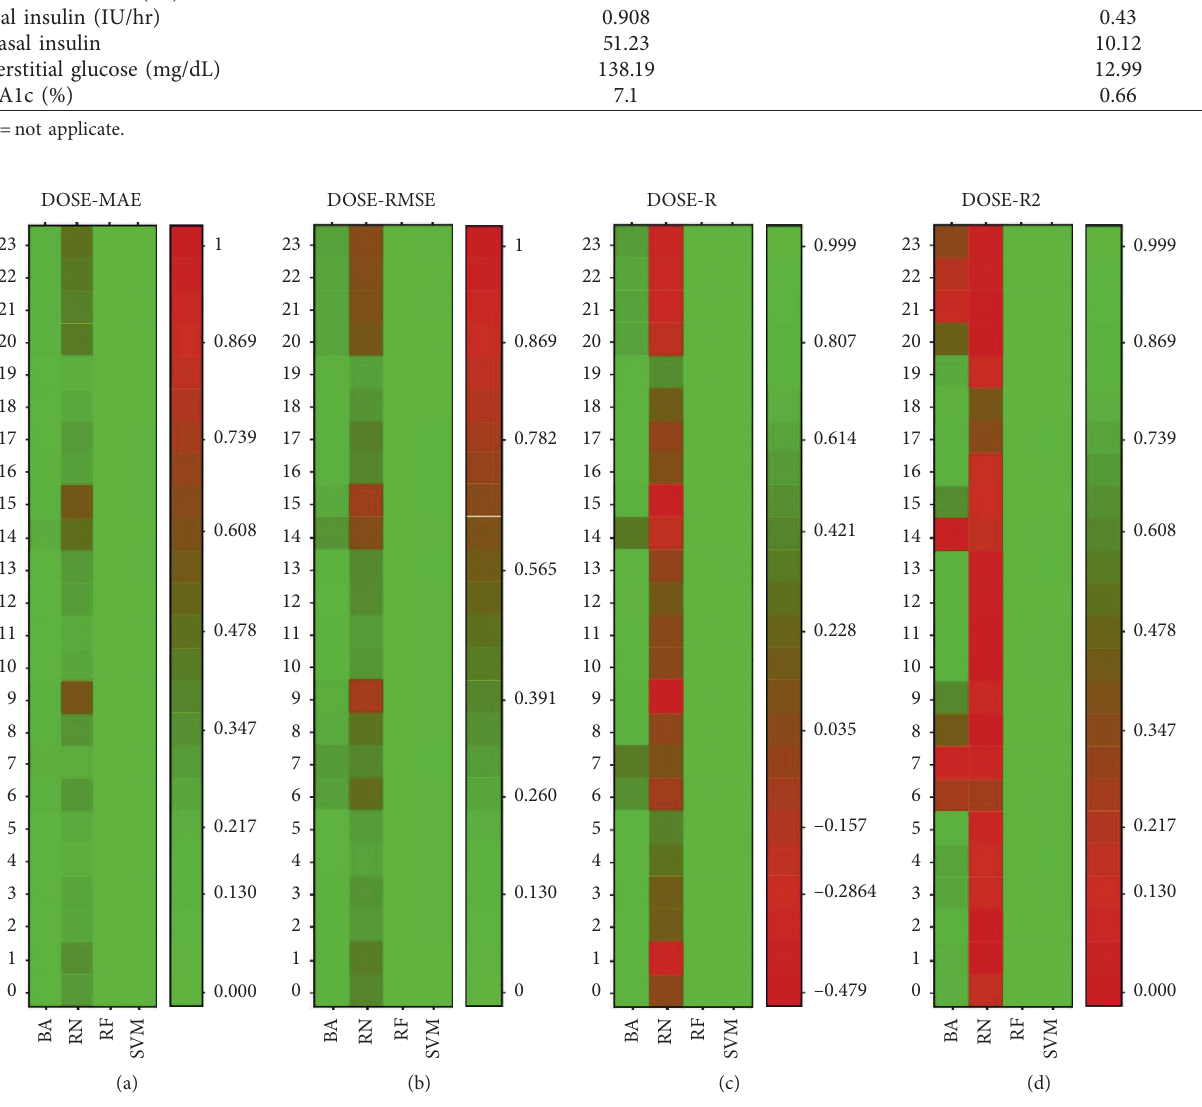
Figure 4: The metrics used to measure the accuracy of the four artificial intelligence techniques for the 24 subsets of data for dose calculation (a). Mean absolute error (b). Root-mean-square error (c). Pearson’s correlation coefficient (d). Coefficient of